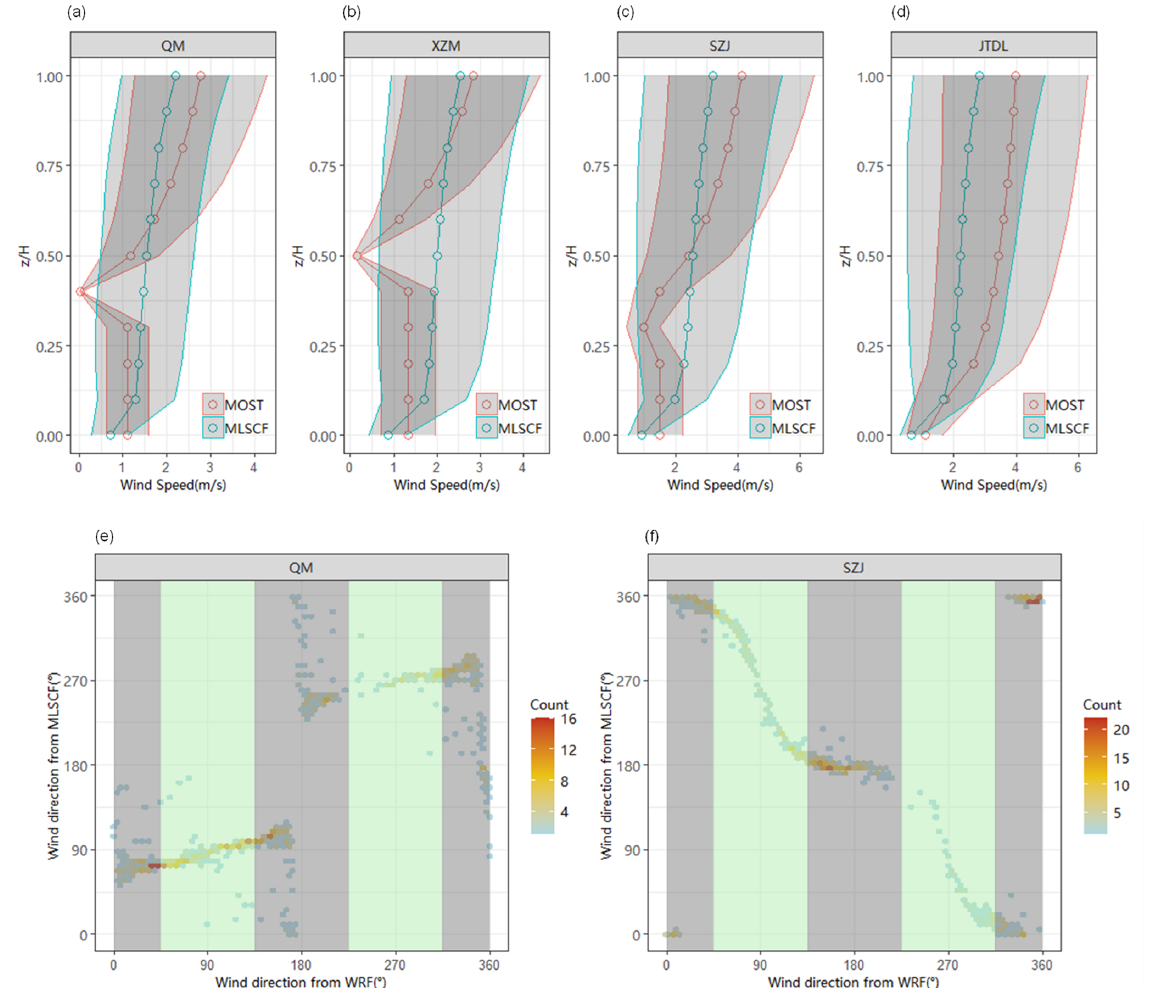
Figure 7. Influence of MLSCF on wind environment in the street canyon. Monthly averaged vertical profile of wind speed from the MOST and MLSCF methods in different street canyons: (a) QM ( H/W = 0.22); (b) XZM ( H/W = 0.35); (c) SZJ ( H/W = 1); (b) JTDL ( H/W = 1.93). The gray shading represents the standard deviation in results of all hours. Hourly wind direction from the WRF model (at roof level) and the MLSCF method (at ground level) in different street canyons: (e) QM ( H/W = 0.22); (f) SZJ ( H/W = 1). As the gray and green shading shown, the background wind over the street canyon provided by the WRF model was divided into four main directions: east, west, south, and north.